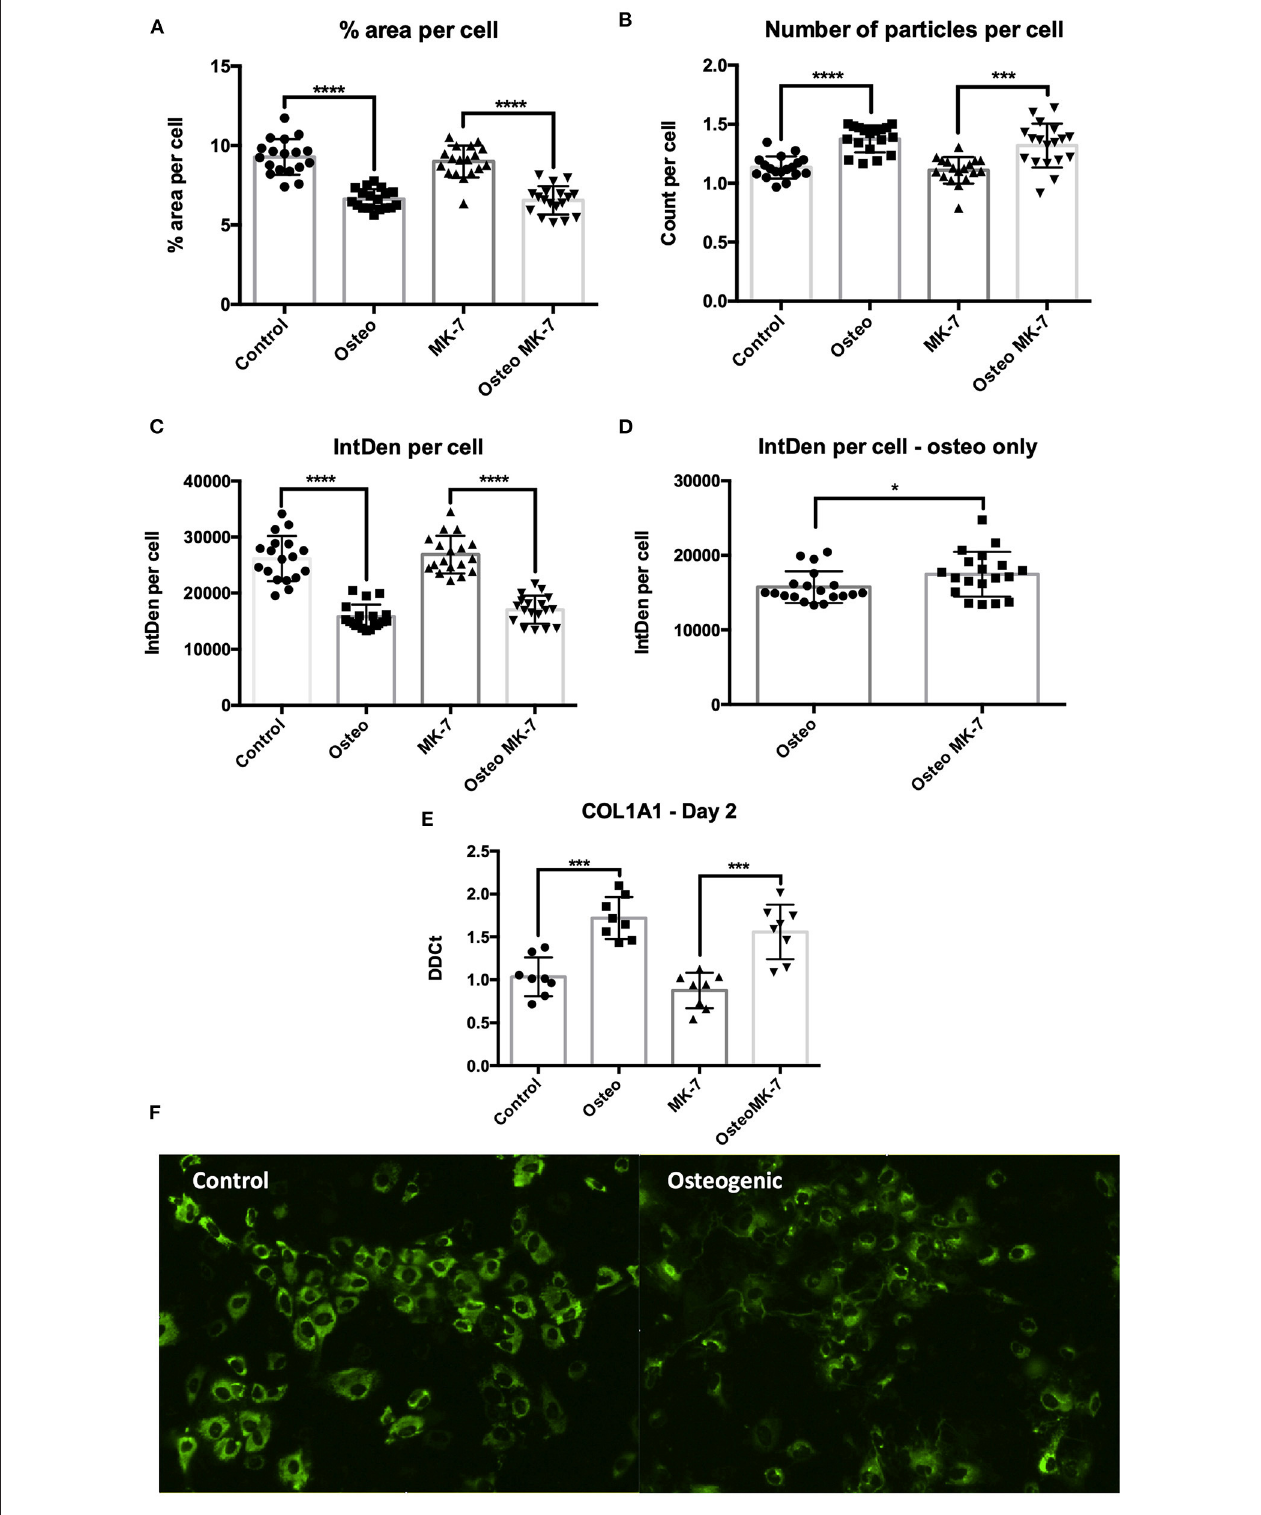
FIGURE 6 | Changes to dynamics of COL1A1 expression. Immunocytochemistry followed by ImageJ analysis reveals that there is a greater surface of COL1A1 expression in control mesenchymal stem cells compared to their respective controls (A,C) . The dynamics by which COL1A1 is expressed can be quantified with regards to number of particles expressing COL1A1, wherein there is a significantly greater number of particles, averaging of a smaller size in both osteogenic